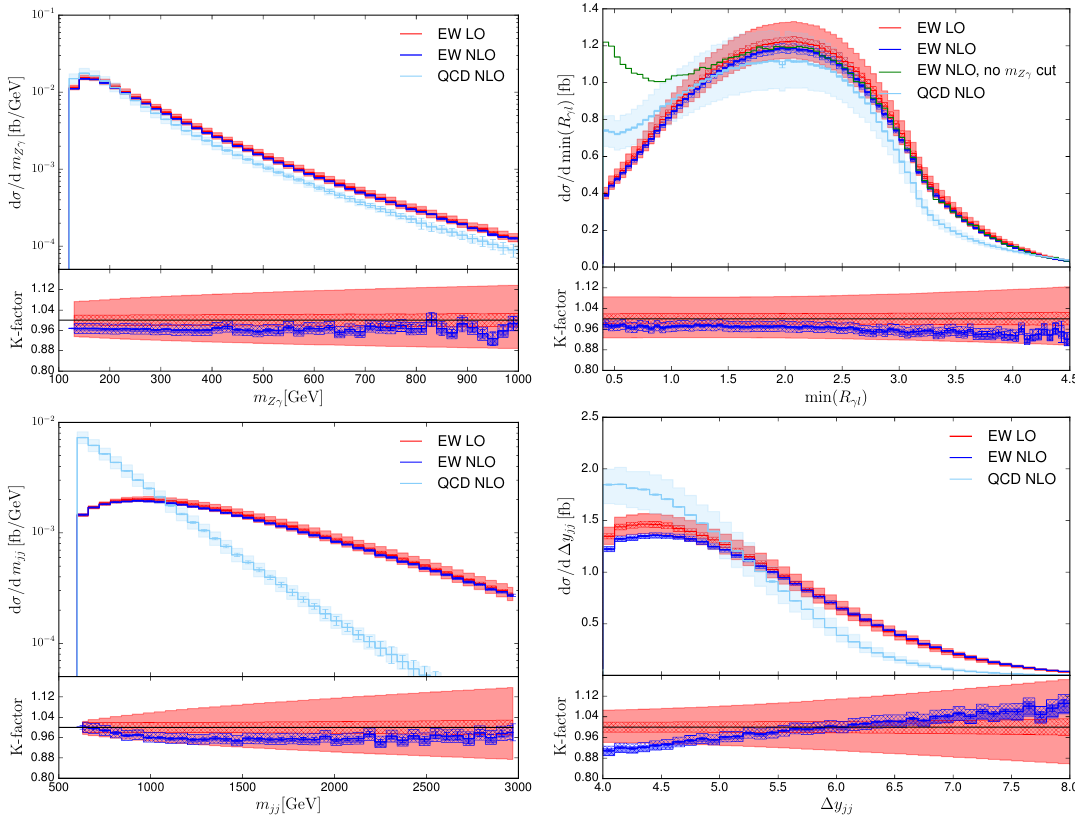
Figure 7 . Di(cid:11)erential cross sections of the EW and QCD induced process, showing the dependence on m Z(cid:13) , min( R (cid:13)l ), m jj , and (cid:1) y jj . For the min( R (cid:13)l ) distributions, we also show the NLO EW cross section without applying a cut on m Z(cid:13) . Solid bands result from scale variation by a factor of two around the central value. For the EW process, the uncertainties associated with the PDF are shown as hatched